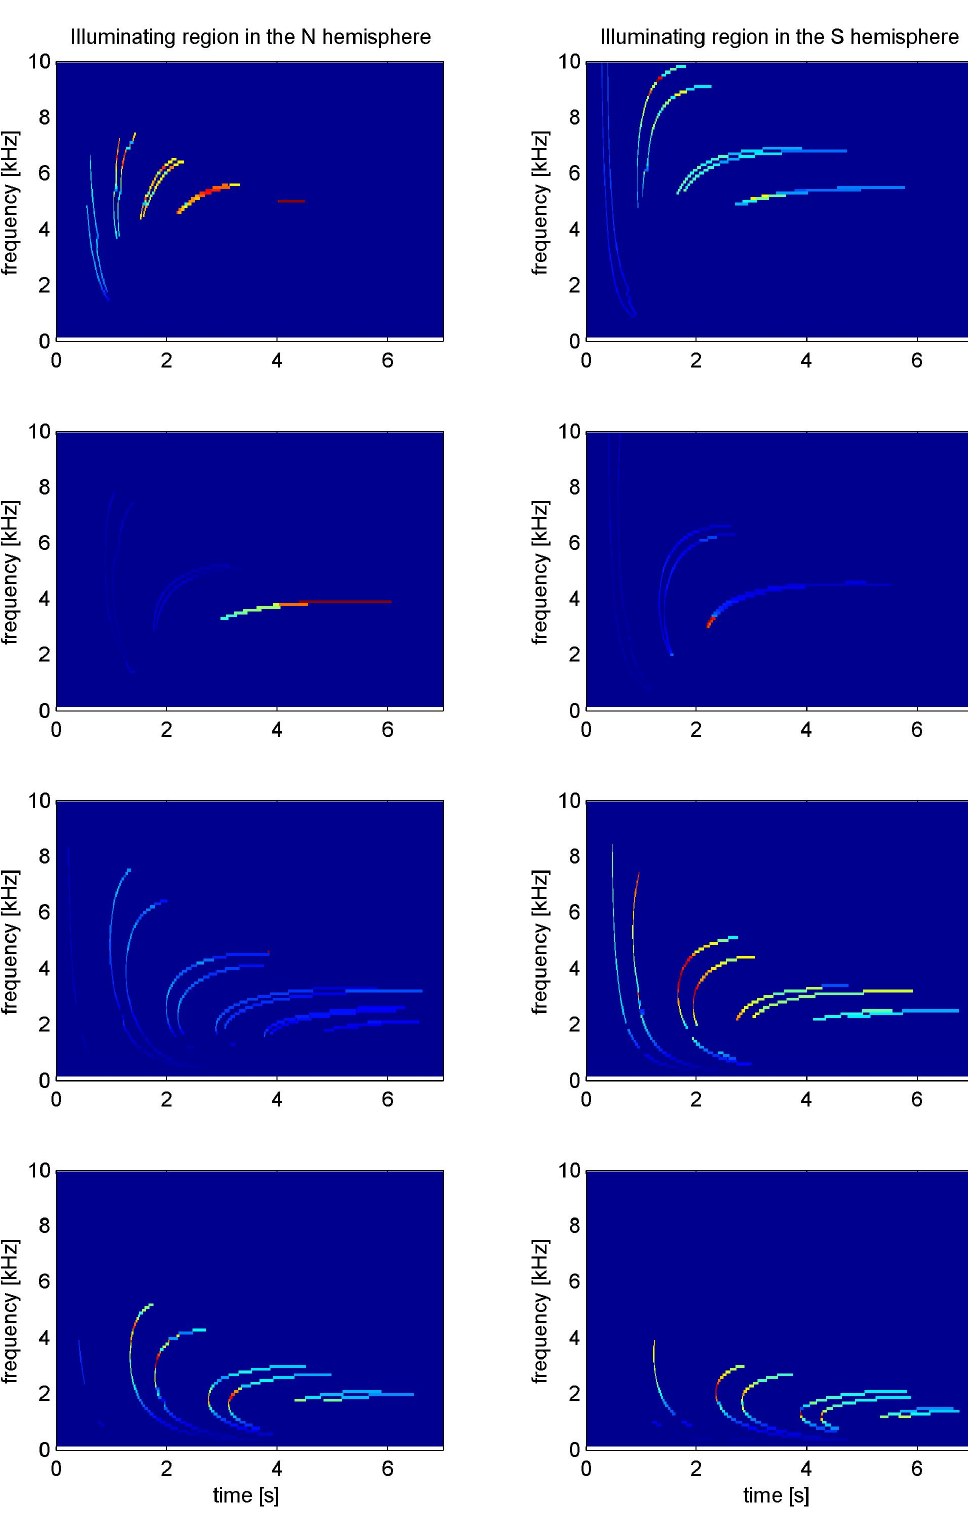
Fig. 10. Simulated spectrograms illustrating the dependence of spectrogram pattern on the observation site. The coordinates of the observation points in the N hemisphere are as follows: left column, from top to bottom, L = 1 . 9 ,λ = 20 ◦ ; L = 2 . 4 ,λ = 27 ◦ ; L = 2 . 5 ,λ = 15 ◦ ; L = 2 . 9 ,λ = 12 ◦ ; right column, from top to bottom, L = 2 . 0 ,λ = 22 ◦ ; L = 2 . 3 ,λ = 27 ◦ ; L = 2 . 6 ,λ = 15 ◦ ; L = 3 . 0 ,λ = 12 ◦ ;